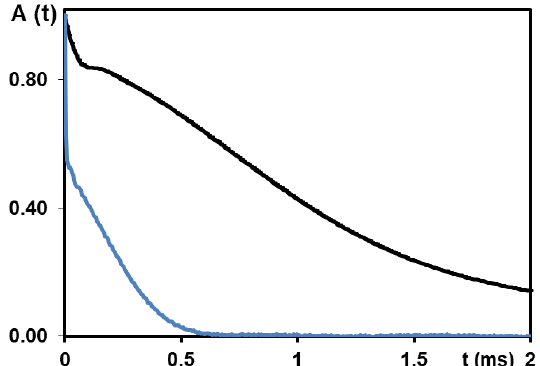
Figure 1. FID signals of protons in two wood samples: dry (blue line) and wet (black line) with moisture > FSP. T = 298K, and the frequency is 400 MHz. The fast relaxing component of the FID characterized wood protons and could be fitted by the Gaussian-sinc function [21,25]. The shape of FID was sensitive to water content in the wood pieces. FID-based method provided the possibility to quantitatively estimate the water–wood interactions on the base of proton populations of the components with different T 2 relaxation times.